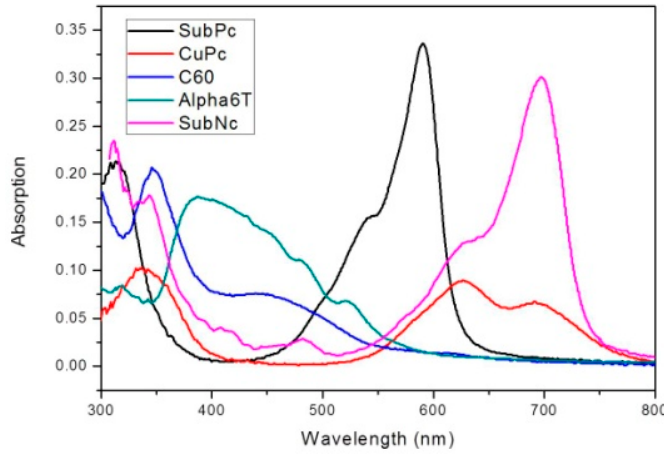
Figure 4. The thin-film optical absorption spectrum of used materials from 300 nm to 800 nm to effectively harvest the solar light.